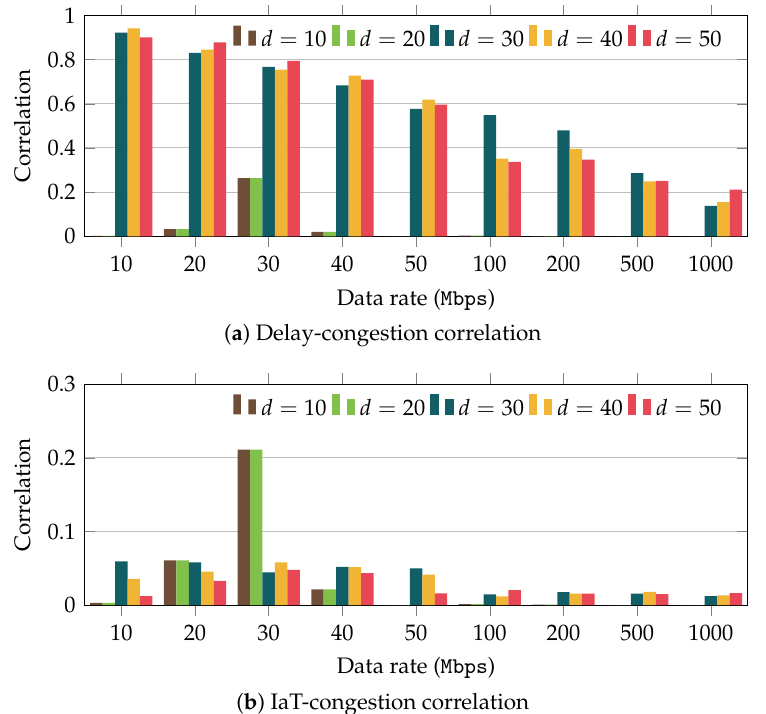
Figure 4. Linear correlation between the RLC buffer and transport level metrics using the greedy